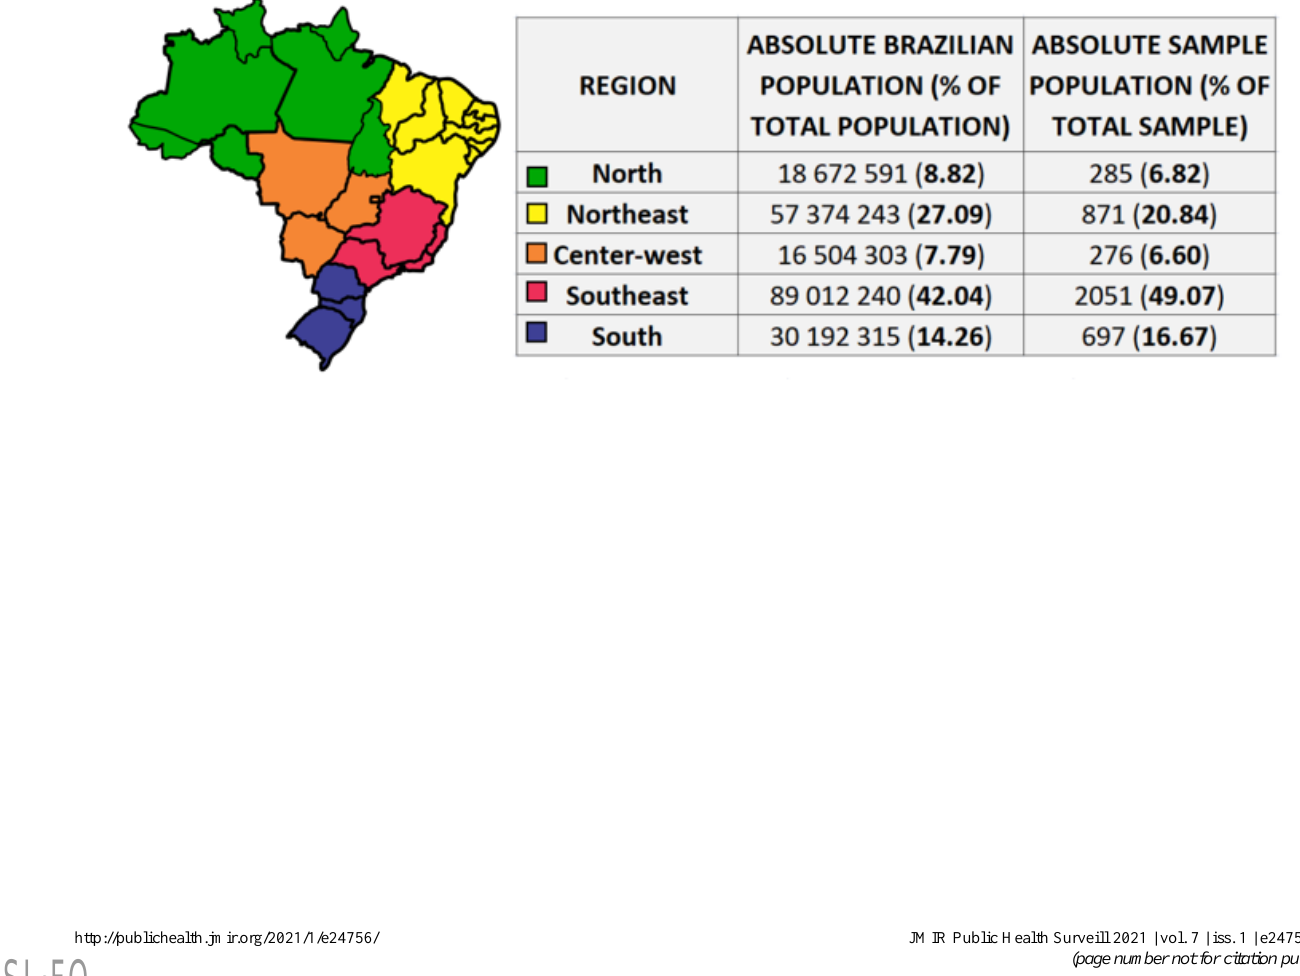
Figure 2. Distribution of the Brazilian population by region and its relationship with the distribution of the study